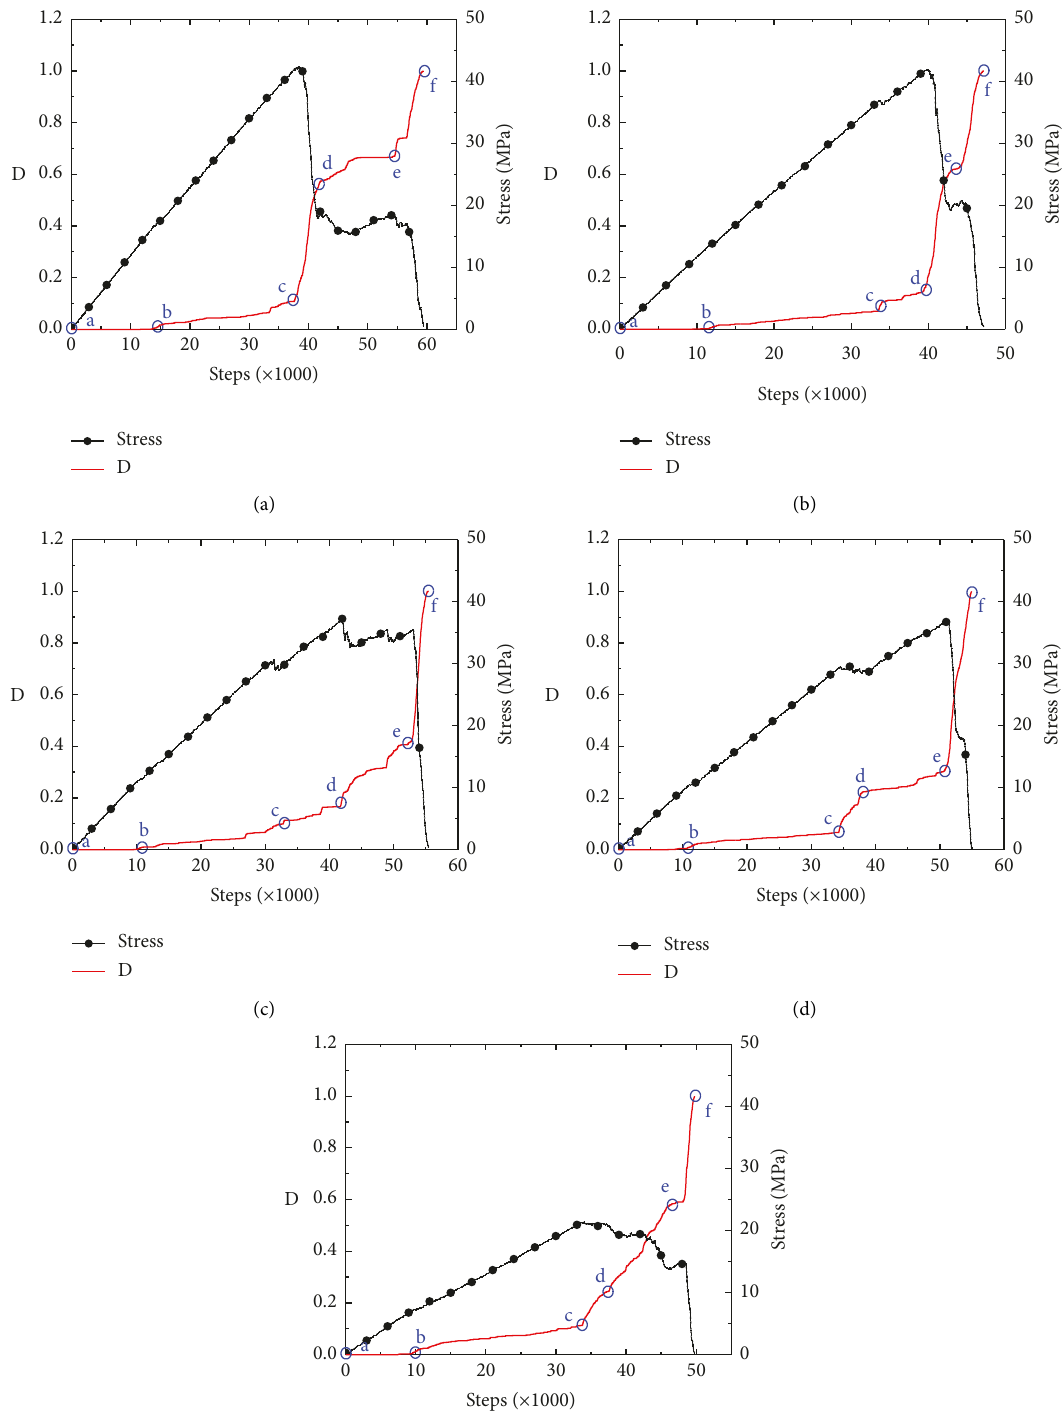
Figure 12: Damage evolution characteristics of rocks with different joint lengths. (a) LB � 10mm. (b)LB � 20mm. (c) LB � 30mm. (d) LB � 40mm. (e) LB �